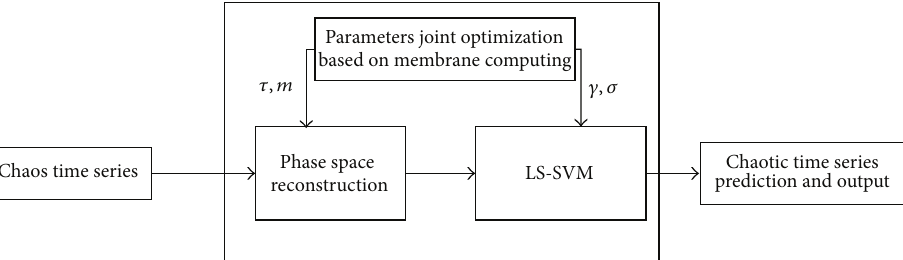
Figure 3: The structure of P-LSSVM prediction model.